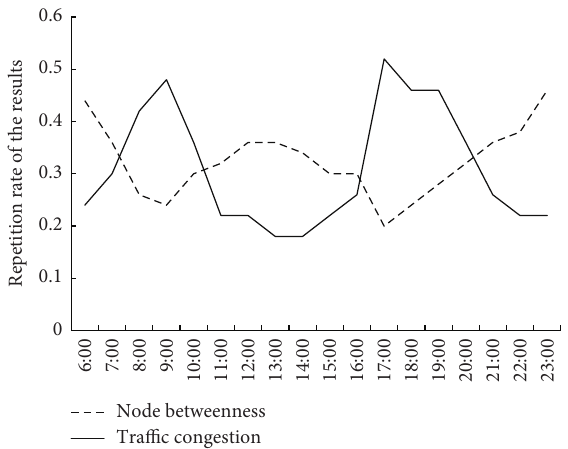
Figure 15: Repetition rate of the identification results of key roadway